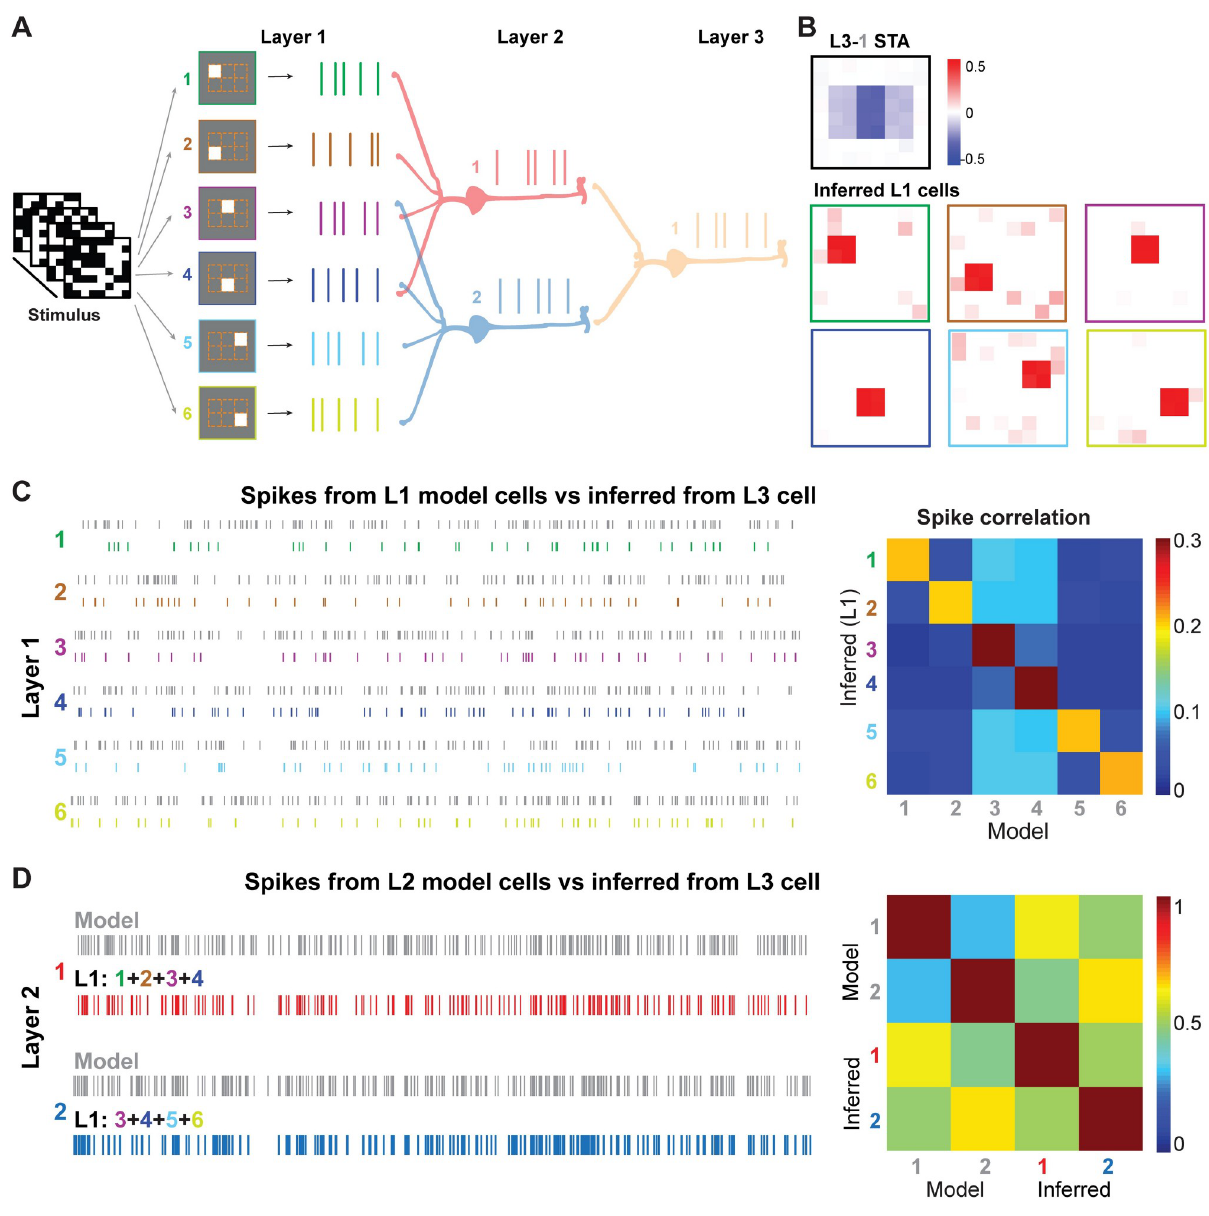
Fig 3. STNMF analysis of a 3-layer model. (A) Illustration of a 3-layer network. Layer 1 (L1) has six cells, where cell 3 & 4 target to both cells in layer 2 (L2). The layer 3 cell receives two layer 2 cells. STNMF was applied to the layer 3 cell. (B) Inferred presynaptic cells from the layer 3 cell. (Top) STA of cell L3–1. (Bottom) STNMF subunits are RFs of inferred L1 cells. (C) (Left) Spike trains generated from layer 1 model cells 1–6 (gray) and inferred from layer 3 cell by STNMF (colored). (Right) Matrices of corresponding correlation of spike trains between model and STNMF inference. (D) (Left) Spike trains generated from layer 2 model cells 1–2 (gray) and combined spikes inferred from layer 3 cell by STNMF (cell 1: red, cell 2: blue). (Right) Correlation matrices of spike trains between model and STNMF inference.